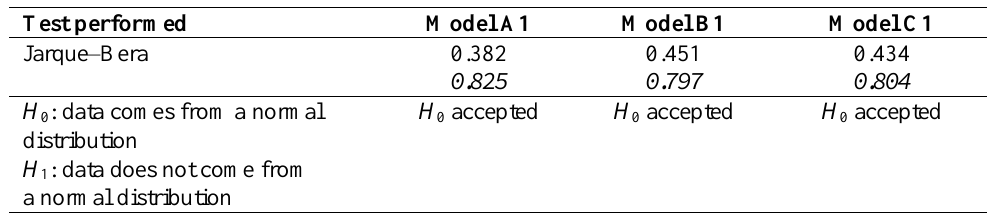
Table 5. Normality Testing